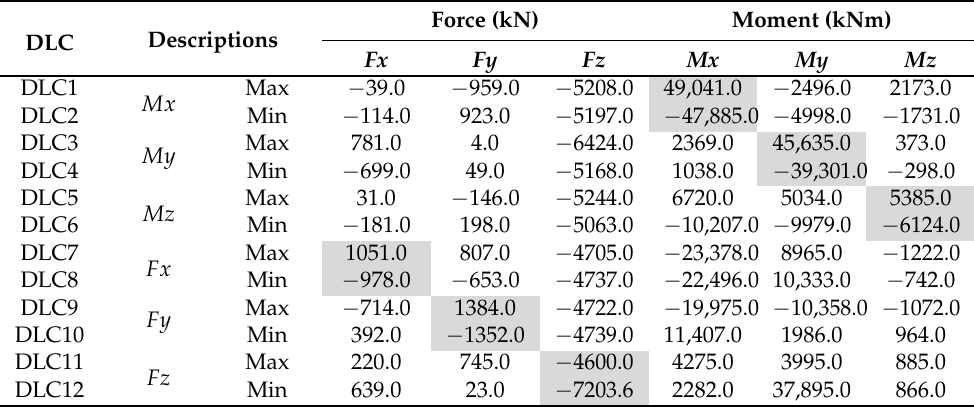
Table 4. Critical DLC loads at the location of IP.